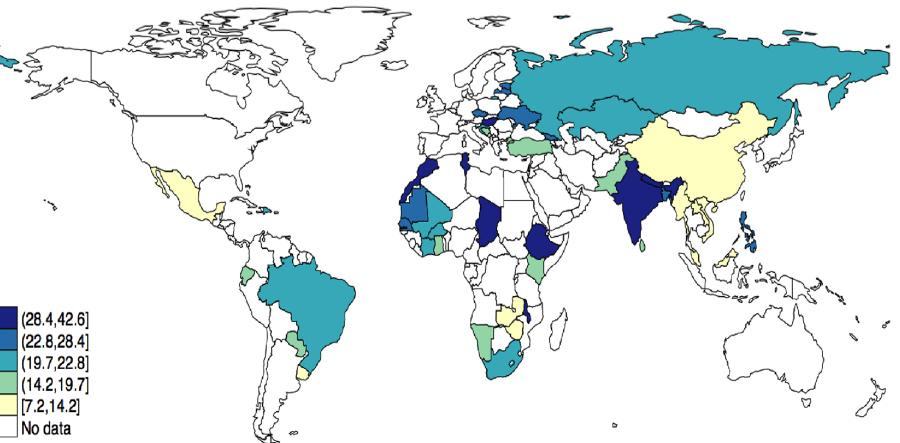
Figure 1. Age- and sex-adjusted prevalence (%) of arthritis. Estimates were calculated using the United Nations population pyramids for the year 2010. The figure was created with STATA 13.1 (StataCorp. 2013. Stata Statistical Software: Release 13. College Station, TX: StataCorp